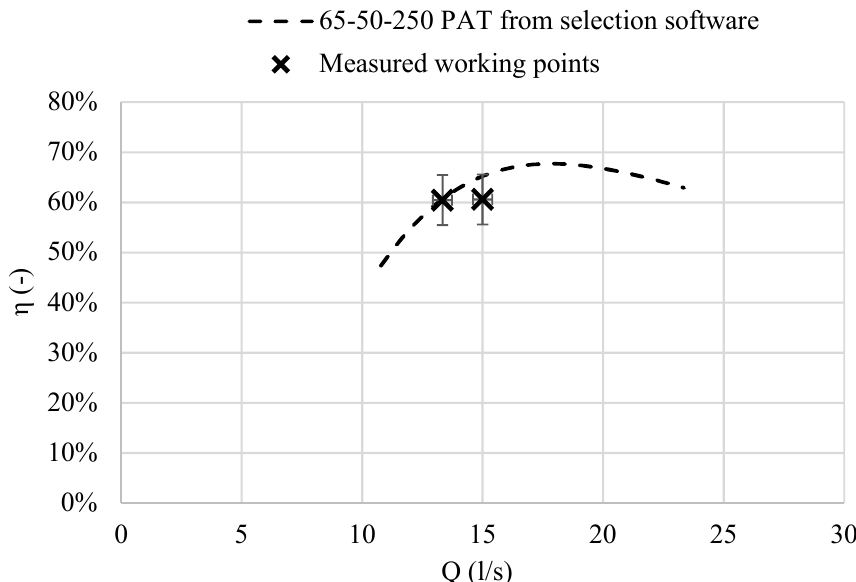
Figure 9. Recorded PAT mechanical efficiency compared to the one calculated by the selection soft- ware.